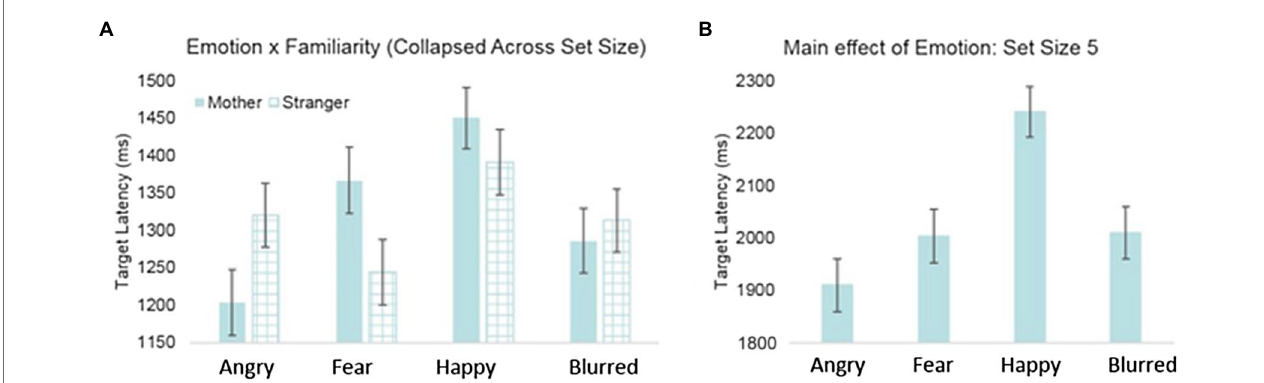
FIGURE 3 | Latency to detect target by (A) emotion and face familiarity and (B) emotion for set size 5.